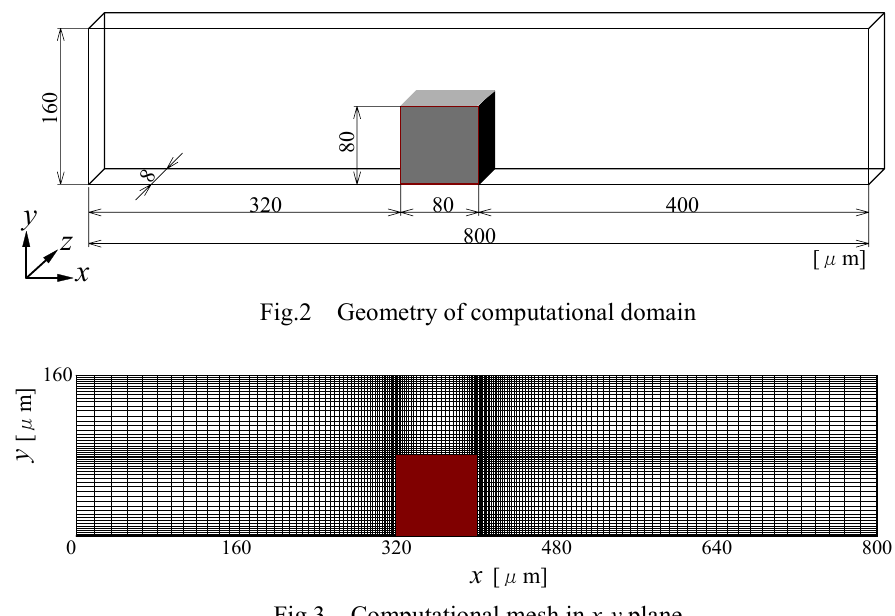
Computational mesh in x-y